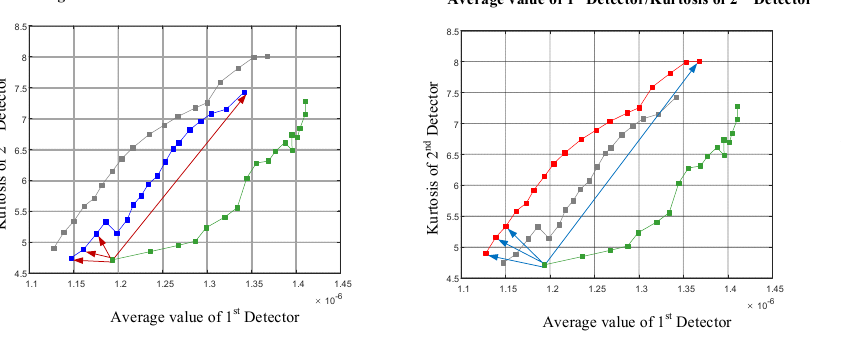
Figure 7. The calculation method for the SA parameter. SA stands for separation ability.